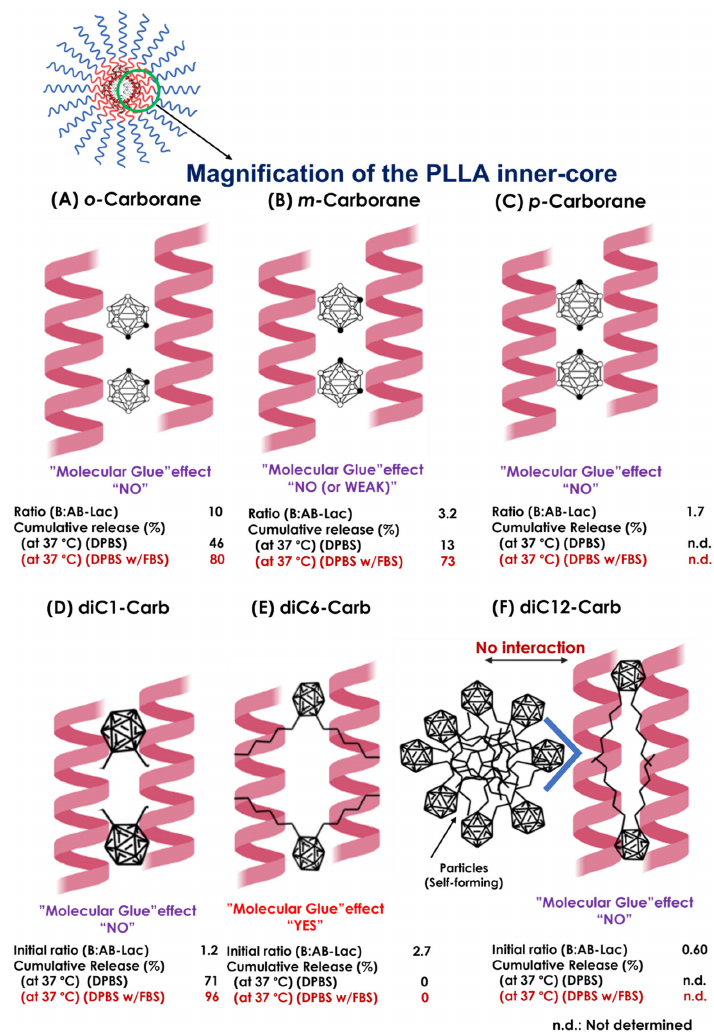
Figure 9. The schematic representations of presumable interactions between the B compound and PLLA core helix in the AB-Lac particles. Possible interactions of the PLLA core with o-carborane ( A ), m-carborane ( B ), p-carborane ( C ), diC1-Carb ( D ), diC6-Carb ( E ), and diC12-Carb ( F ). The ratio (B:AB-Lac polymer) refers to Table 1. The molecular glue effect explaining the two PLLA helix interaction patterns with their enantiomer PDLA was previously reported by Tsuji et al. on active polymers (L- configured or D-configured polymer) where unsubstituted/substituted optically active